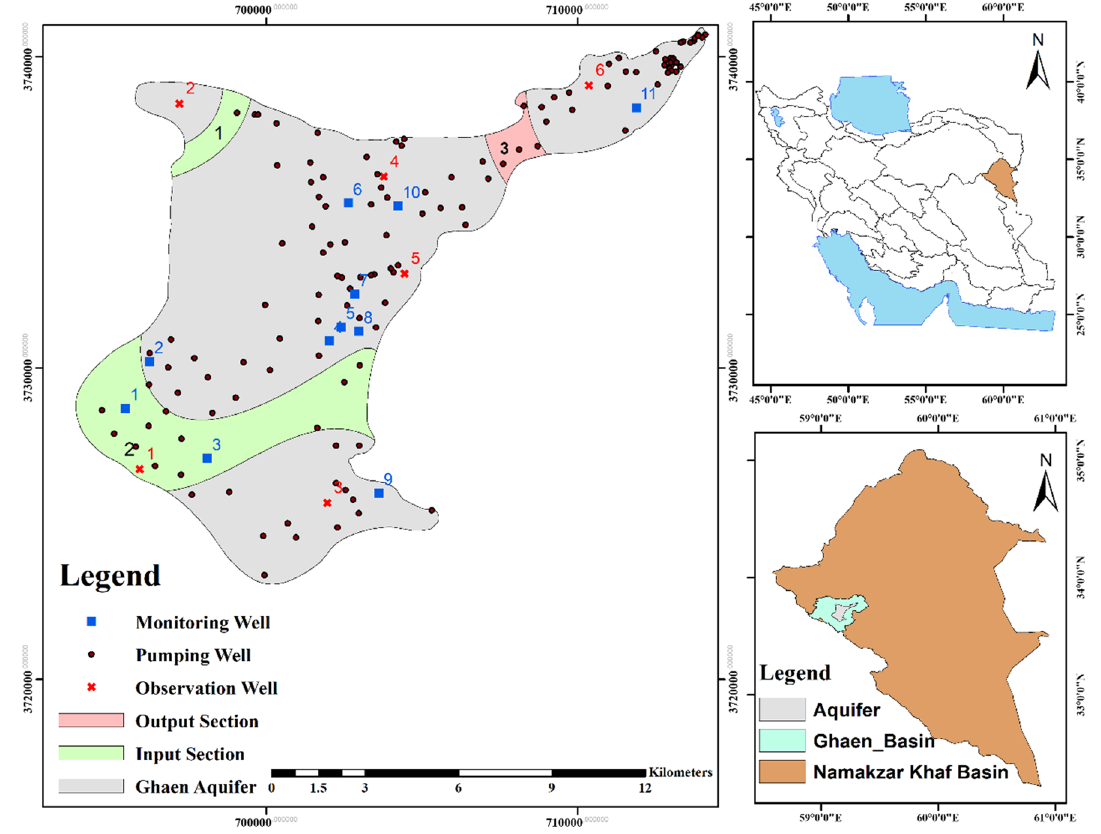
Fig. 2 Study area (Ghaen